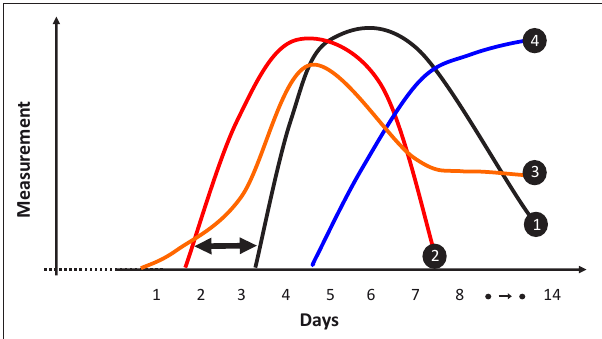
FIGURE 1: Diagnostic windows for FMD showing temporal distribution of FMDV in different biological samples ([1-black] vesicular epithelium; [2-red] blood and [3-orange] mucosal swabs) and (4-blue) FMDV-specific antibodies in sera. The dotted axis-line represents incubation period that is dependent upon infectious dose, virus strain, species and other host determinants. This figure was generated using representative ‘in contact’ experimental cattle data from previous studies (Alexandersen et al. 2003) and unpublished data from